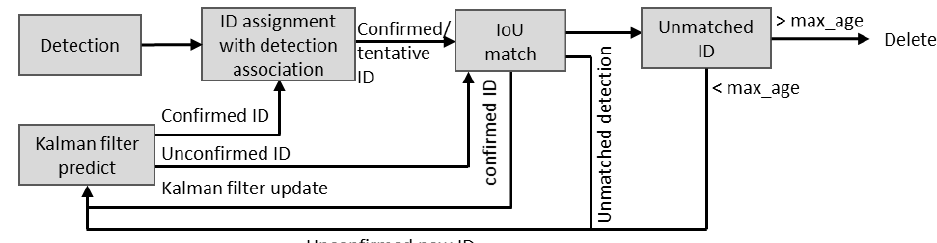
Figure 5. Pig-tracking algorithm adopted in Deep-SORT. A virtual ID is assigned to each detected pig in the first frame, and the IDs are given to the respective pigs based on the matching IoU in the subsequent frames.